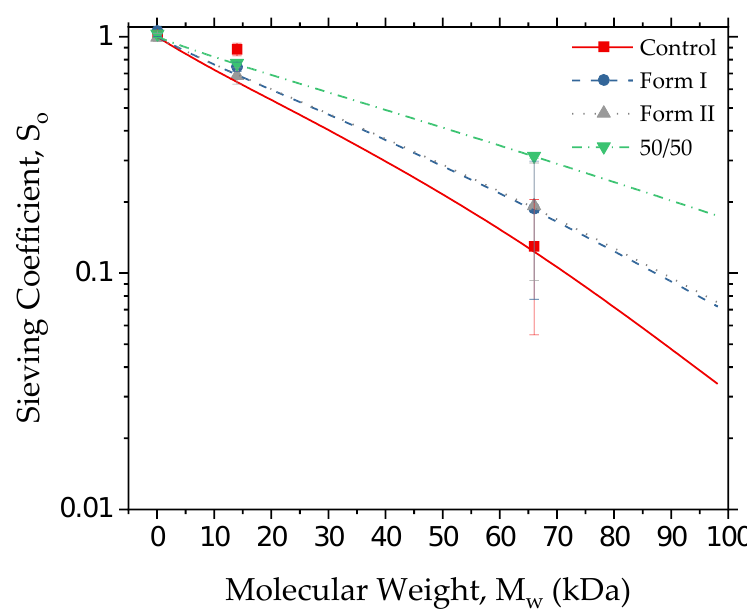
Figure 3. Experimental (points) and theoretical (lines) sieving coefficients (S o ) plotted on the y-axis, and protein/urea molecular weight plotted on the x-axis.